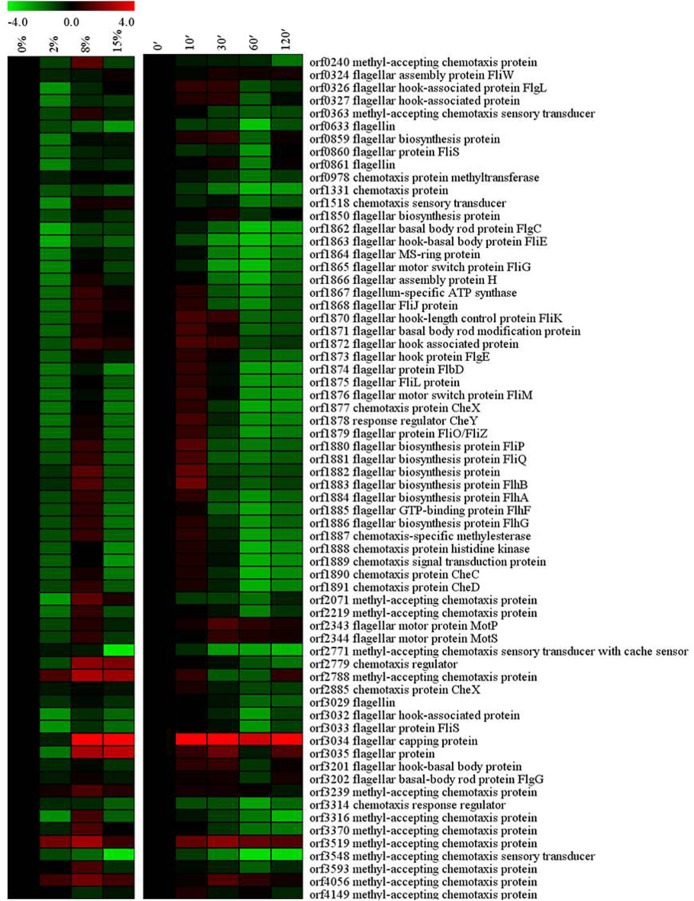
Alterations in flagellar system related genes.Expression profiles are displayed on the basis of log2 ratios.